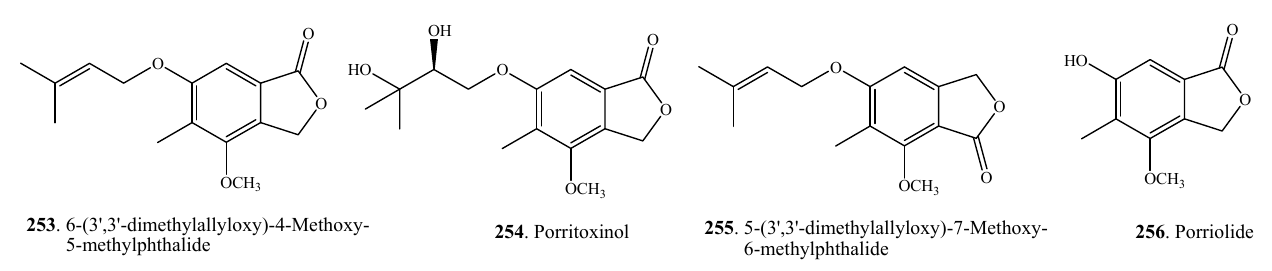
Figure 13. Phthalides isolated from Alternaria